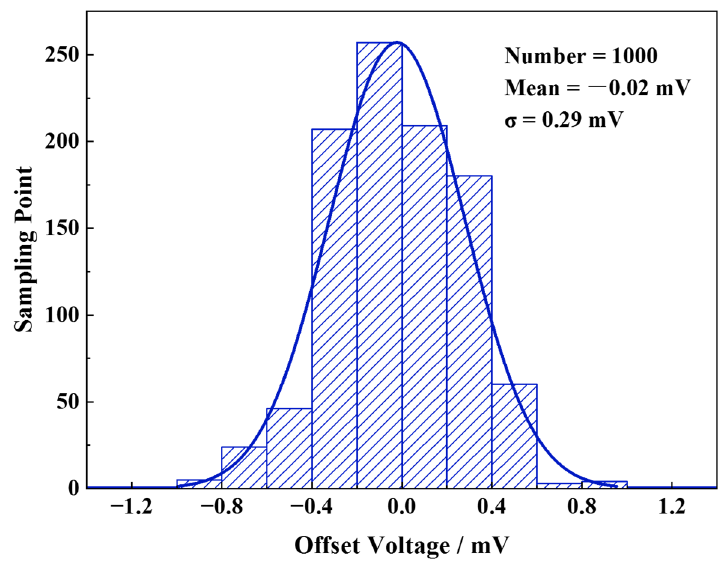
Figure 8. The Monte-Carlo simulation of the calibrated comparator.